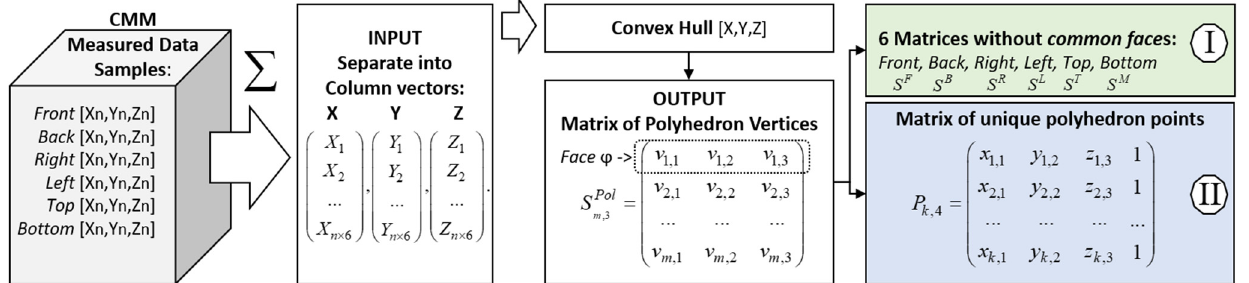
Fig. 6. The fl owchart of the data pre-processing with the output of two data structures I and II.